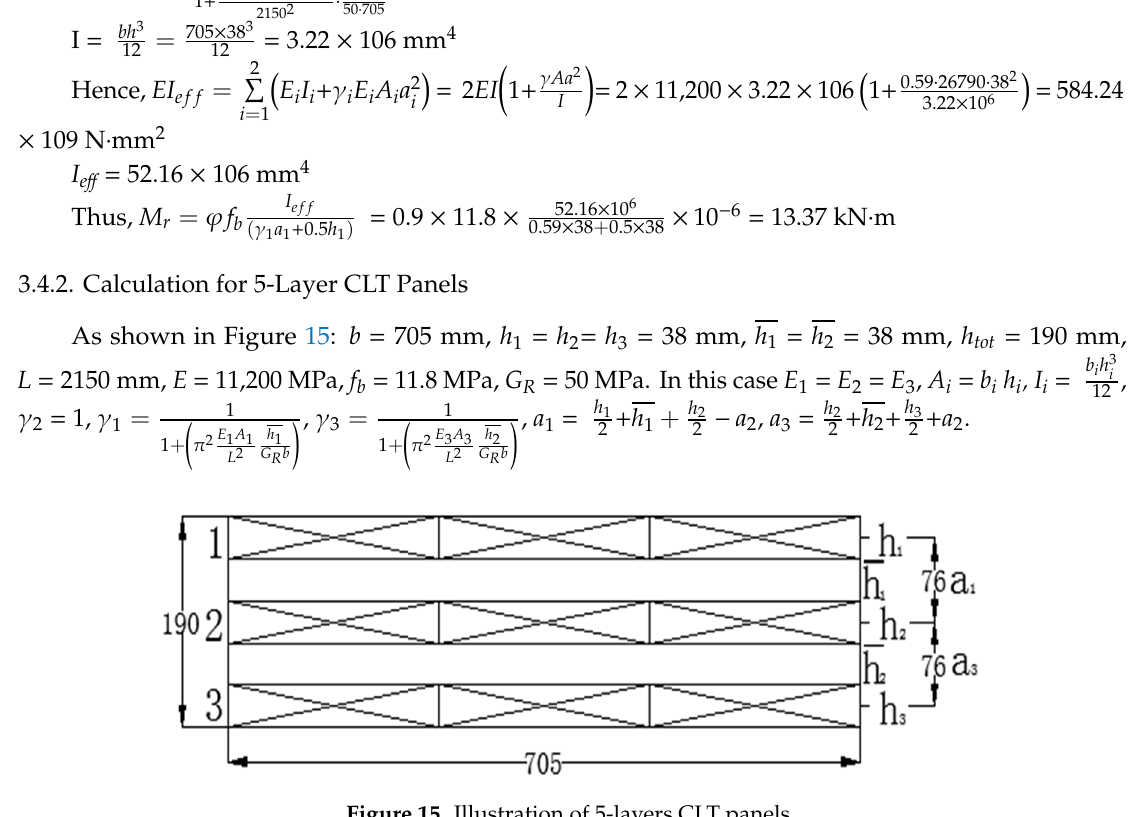
Figure 15. Illustration of 5-layers CLT panels.